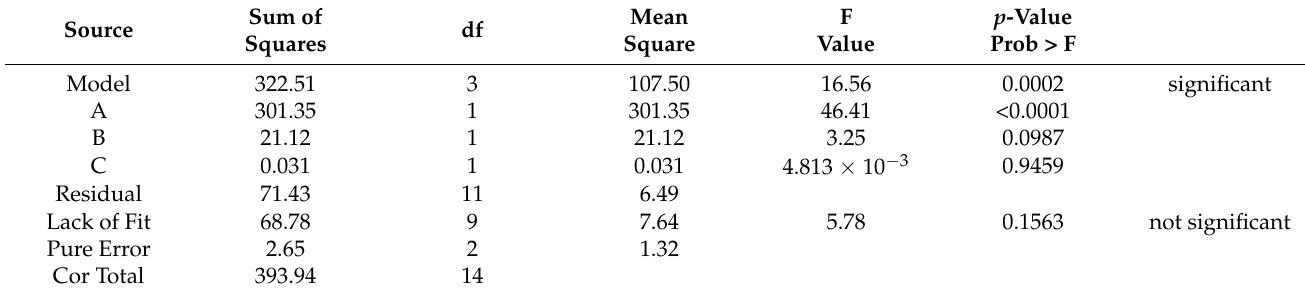
Table 7. ANOVA for the response surface linear model.